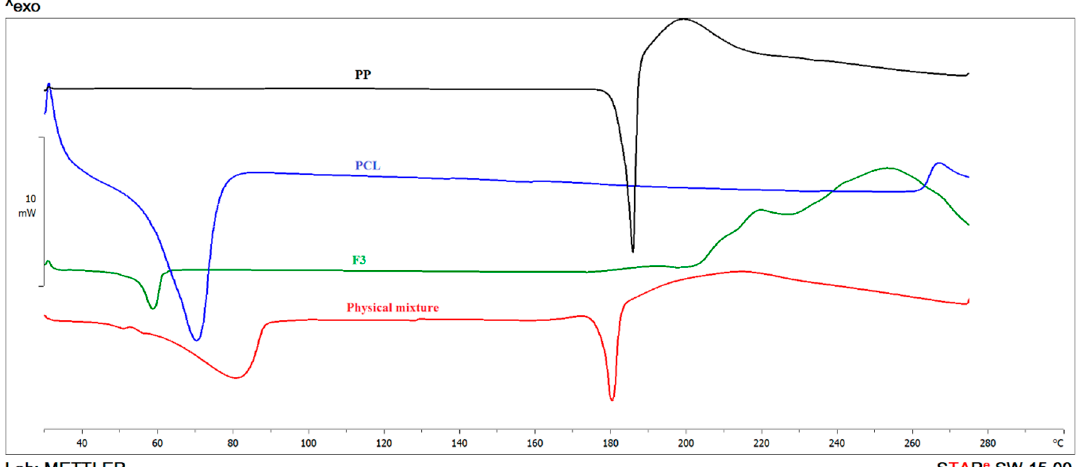
Figure 3. DSC thermograms of; PP, PCL, F3, and physical mixture.